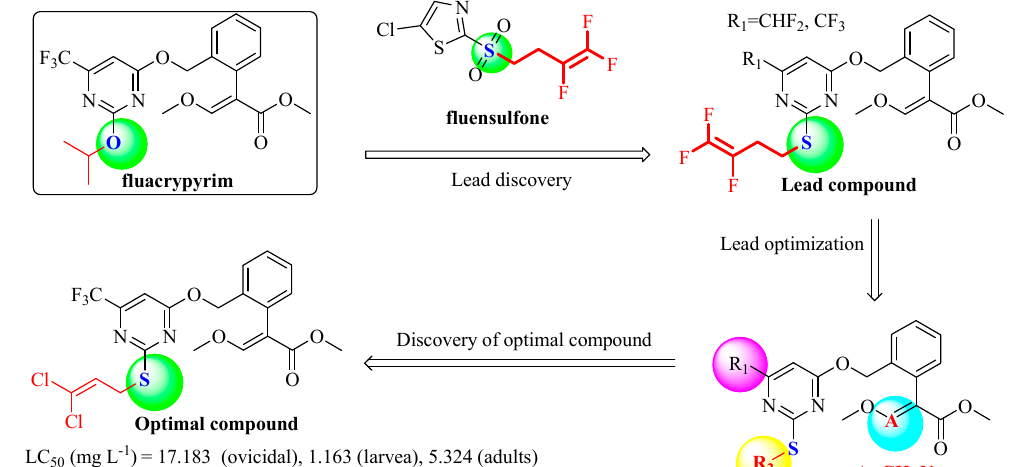
Figure 3. Design strategy of the target compounds.